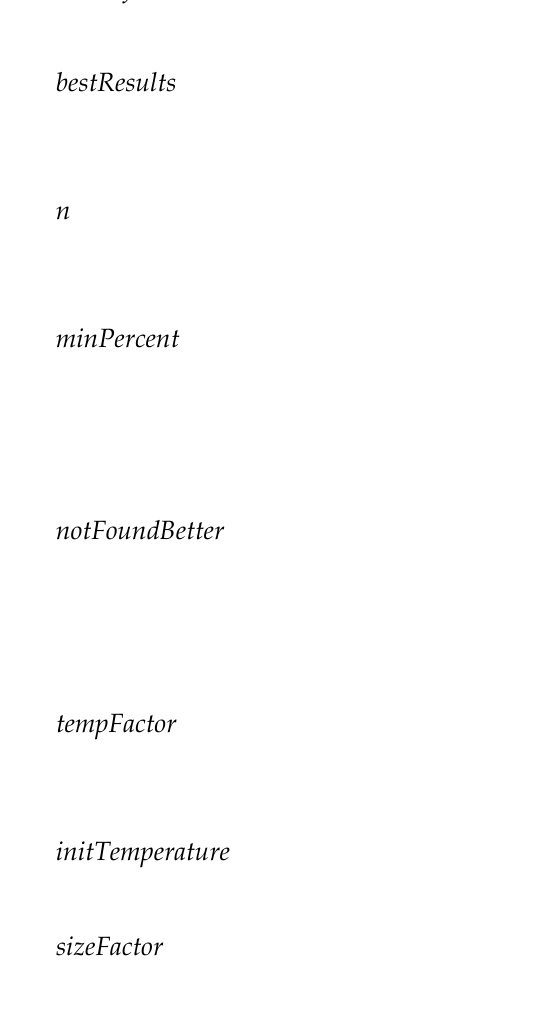
Algorithm A.1 Simulated annealing – adaptive neighborhood